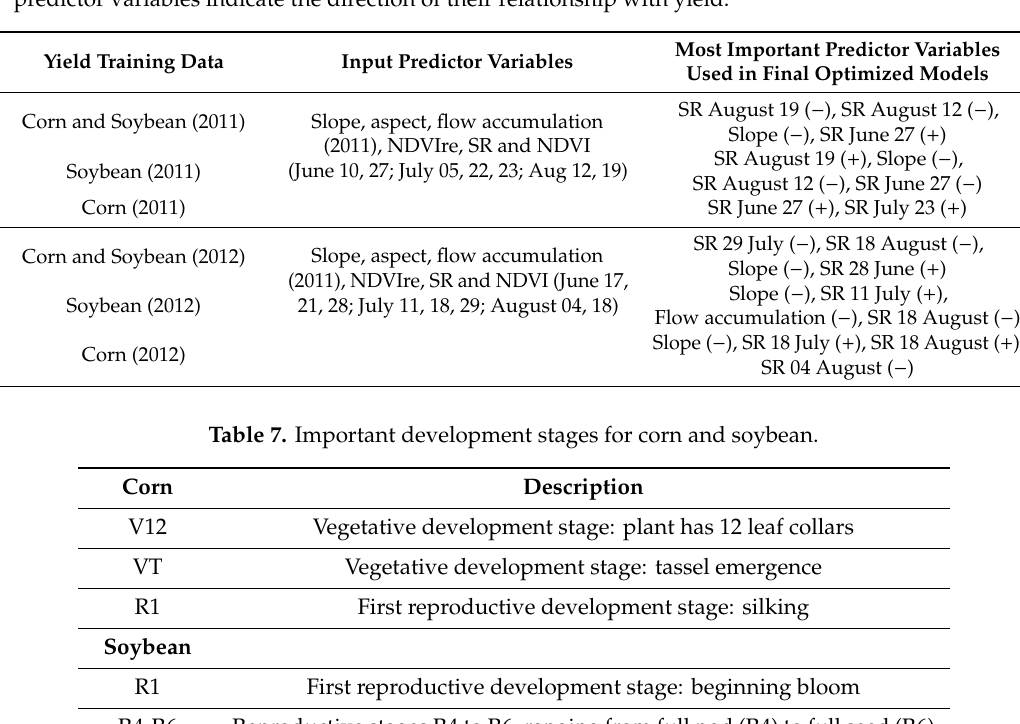
Table 6. Overview of the input predictor variables and the most important predictor variables according to Garson’s algorithm and connection weights. Negative and positive signs for the most important predictor variables indicate the direction of their relationship with yield.